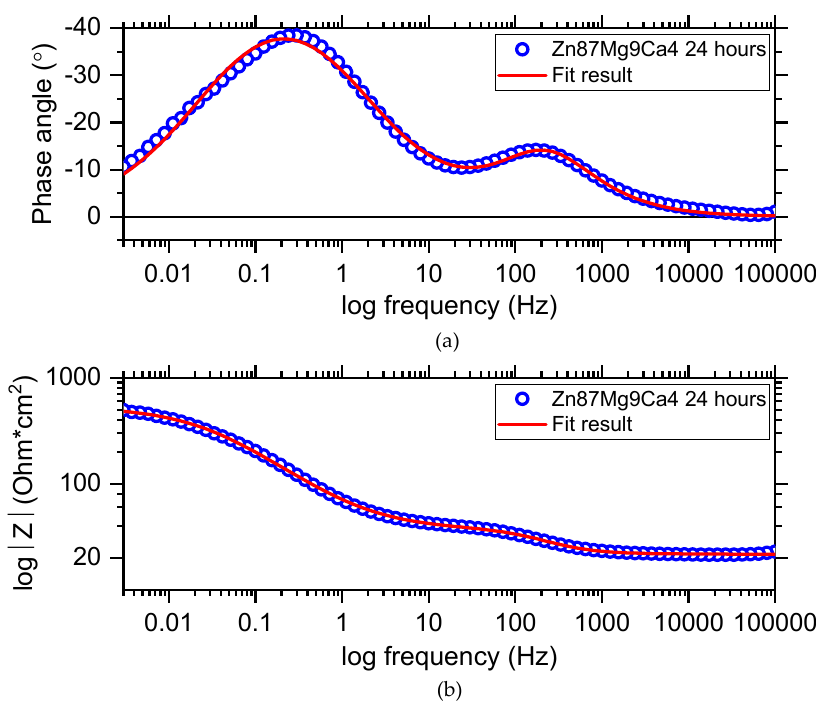
Figure 15. Bode diagram ( a , b ) obtained for the Zn 87 Mg 9 Ca 4 alloy sample immersed at open circuit potential in Ringer’s solution at 37 ° C for 24 h.